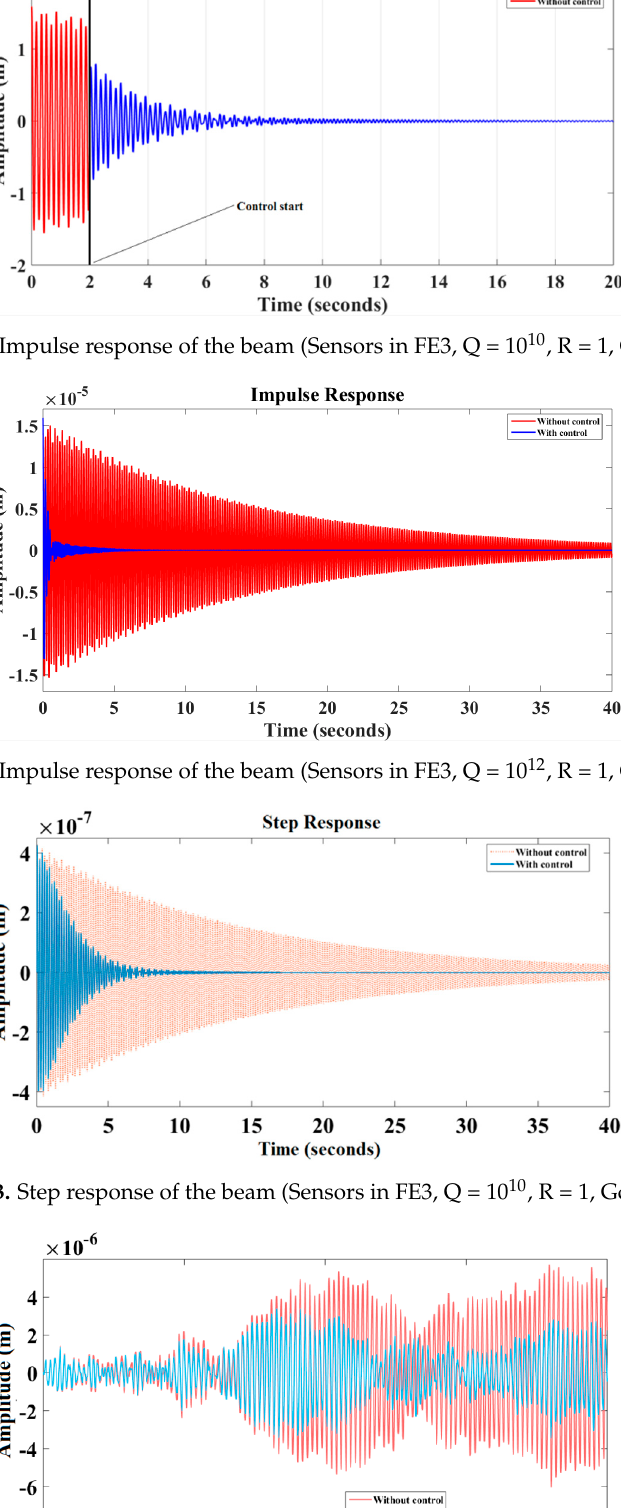
Figure 15. Impulse response of the beam (Sensors in FE4, Q = 10 8 , R = 1, Gc = 100). Figure 16. Impulse response of the beam (Sensors in FE4, Q = 10 10 , R = 1, Gc = 100).